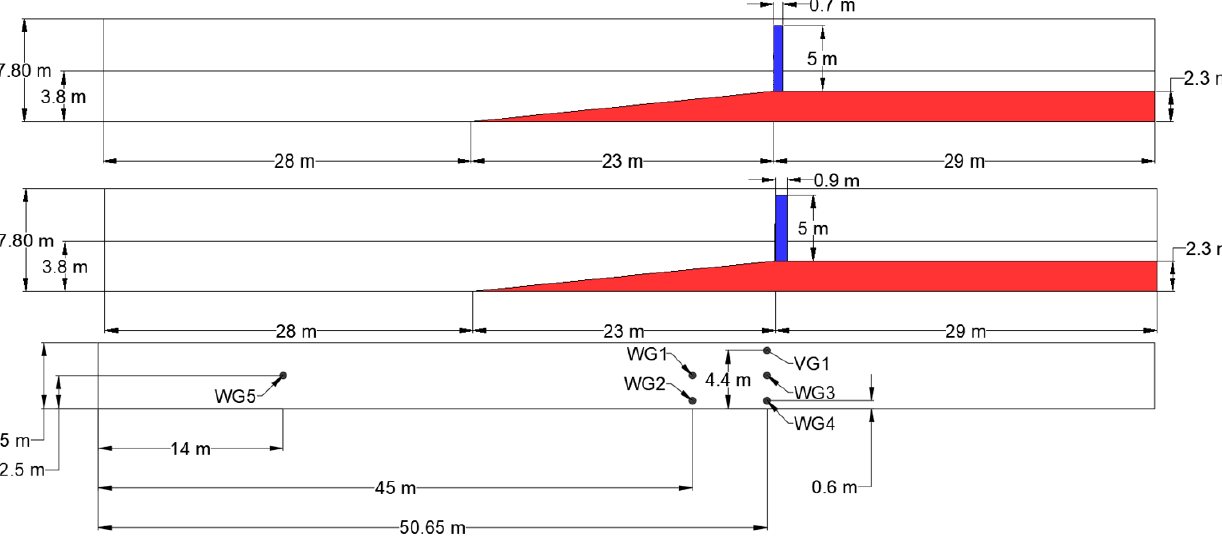
Figure 2. Schematic representation of the NWT with the conical substructure: front view. Fourteen gauges were placed near the substructures along the z direction every 30 ° . The details of the fourteen gauges are shown in Figure 3 and Table 3. Figure 3. Schematic representation of the gauges near the substructures along the z direction every 30°. The velocity and dynamic pressure were measured near the vertical cylindrical sub- structures every 30°. The details of the measuring positions are shown in Table 4.